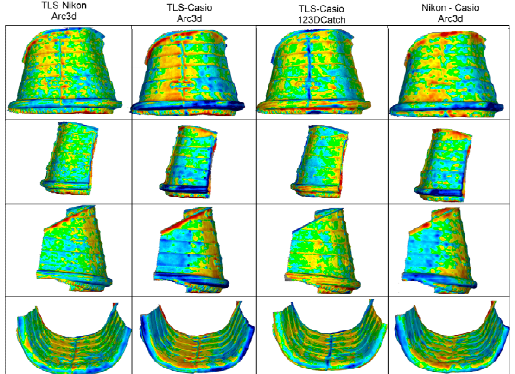
Figure 11. Right leg saver. Rivets and line structures.